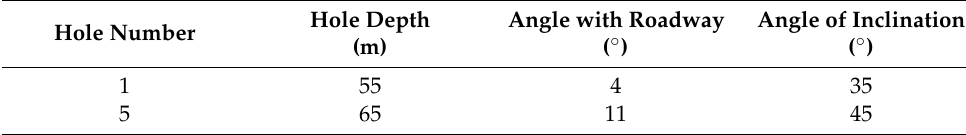
Table 1. Construction parameters of probe hole.